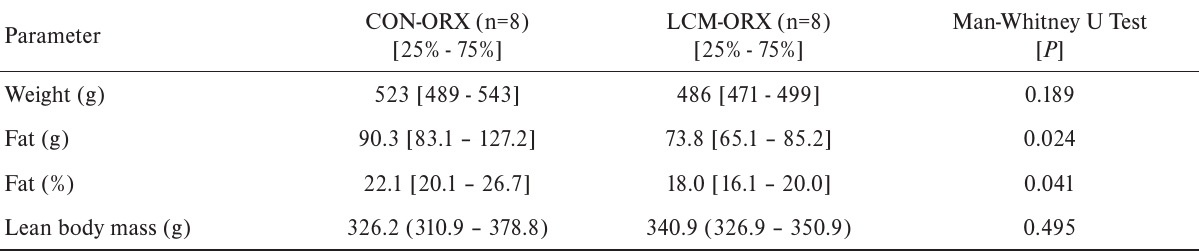
Table 1. Body weight and fat mass.